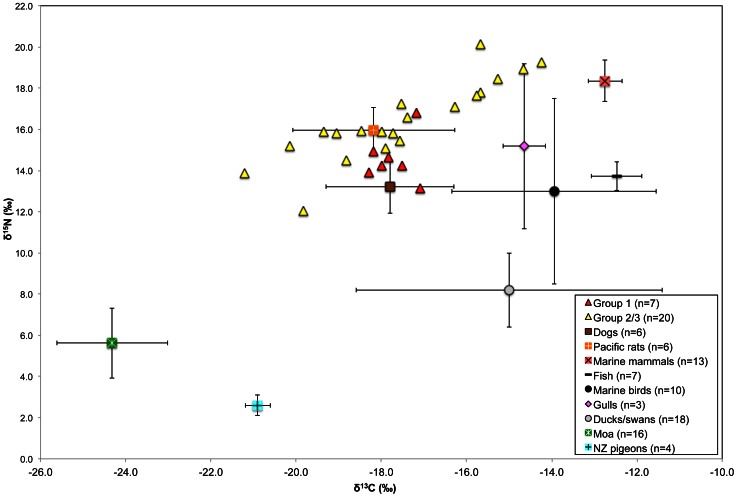
Wairau Bar human bone collagen δ13C and δ15N values with reference to the dietary baseline.